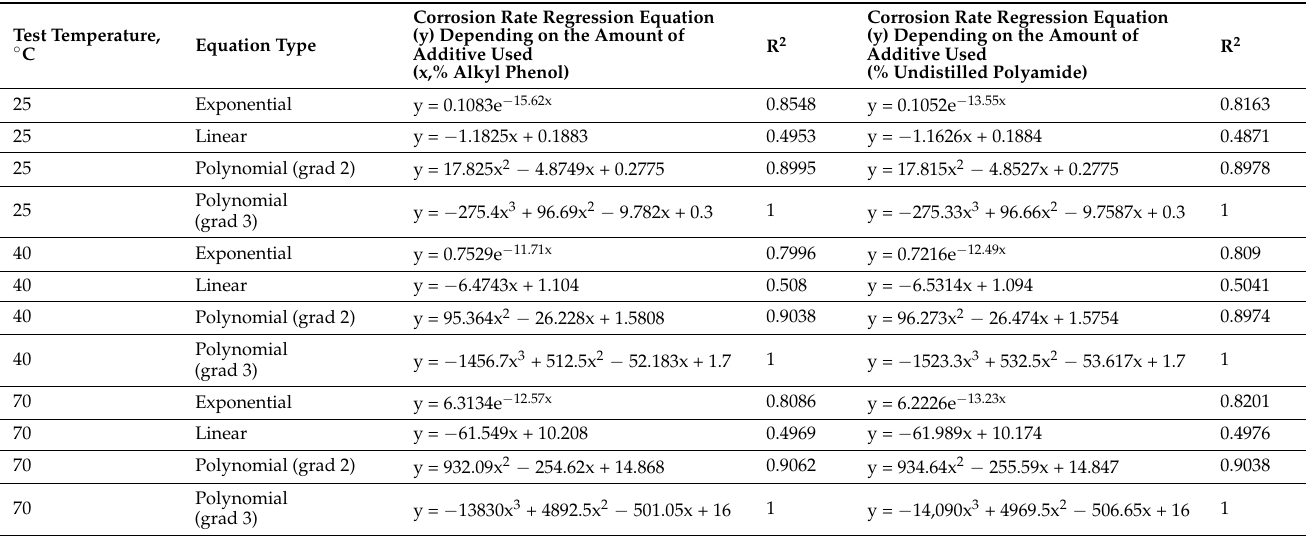
Table 8. Corrosion rate equations (y) as a function of temperature, HCl content of the solution (5%), and the amount of antacid additive used (x,%).